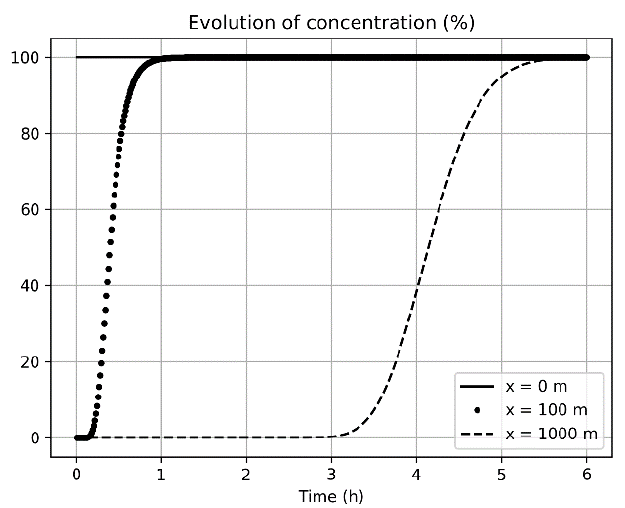
Figure 7. Computed simplified analytical solution implemented in Organics in time at x = 100 m and x = 1000 m.